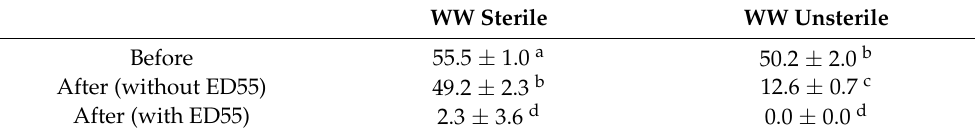
Table 2. Acute toxicity tests performed with Allivibrio fischeri (% bioluminescence inhibition). WW Sterile WW Unsterile Before 55.5 ± 1.0 a 50.2 ± 2.0 b After (without ED55)